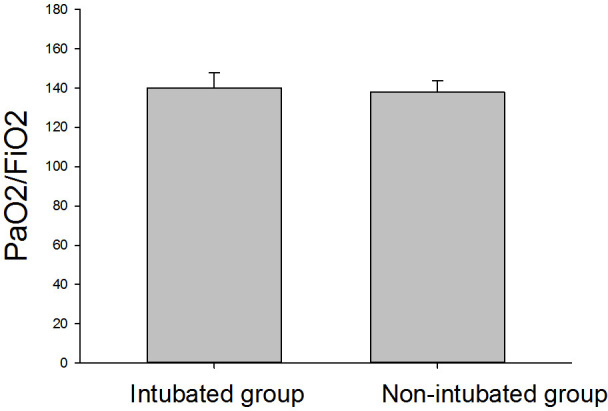
Comparison of oxygenation index in the two study groups on T1.